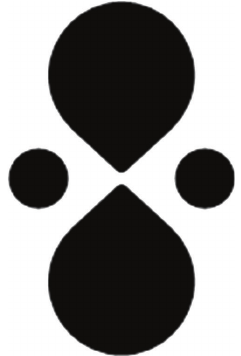
Figure 1: NFC icon based on the shape of the operation range of an RFID